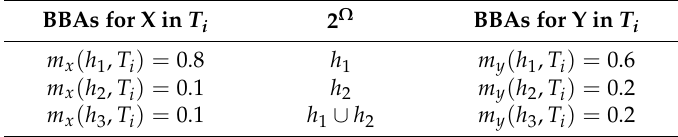
Table 1. Basic belief assignments for appliances X and Y (example).